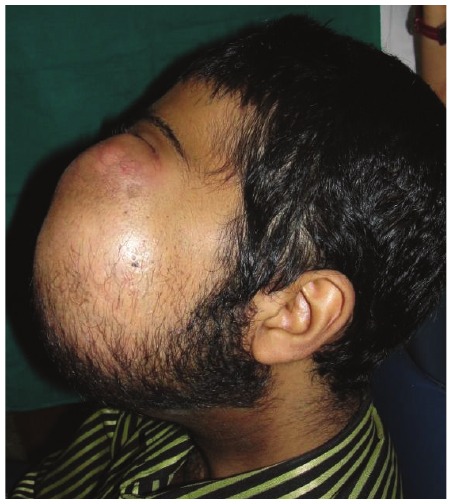
Figure 2: Lateral view.